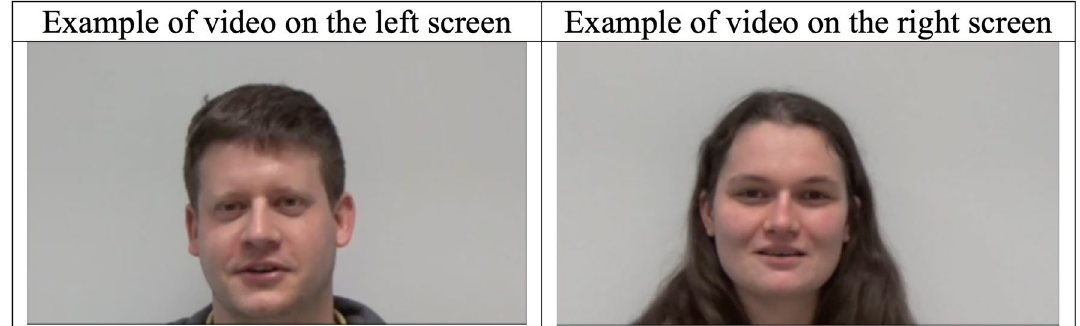
Figure 2. Screenshots of 2 videos presented simultaneously during 1 trial. The videos change at each trial (thus each horse saw 6 different women and 6 different